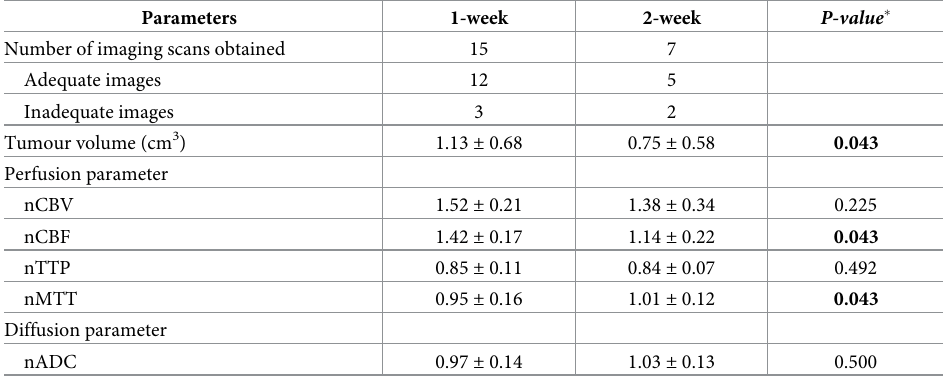
Table 2. Serial follow-up imaging characteristics of the canine GBM model.